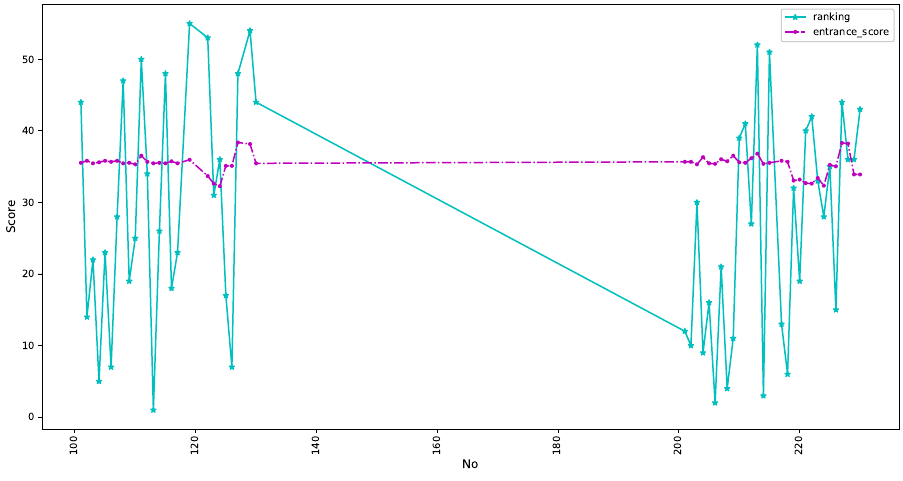
Figure 9. Overall ranking of 55 students.